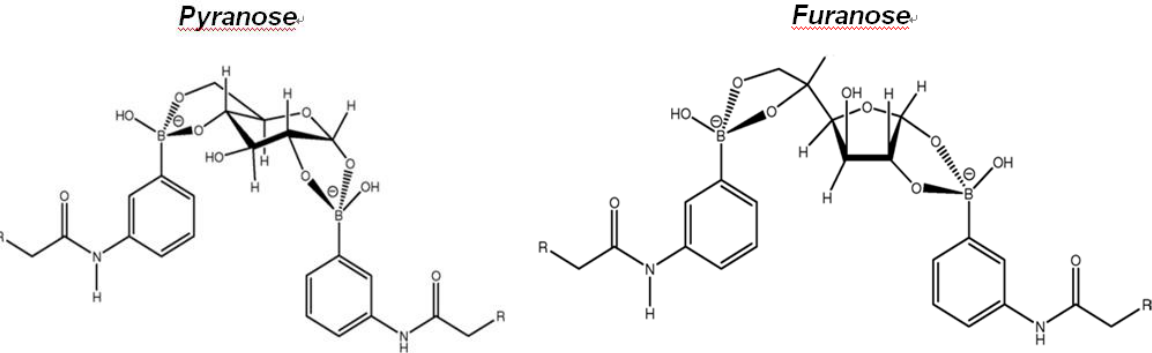
Figure 2. Proposed structures for glucose-PBA bridges between separate chains [8,12,27–29]. Glucose may be in its pyranose ( left ) or furanose ( right ) form. Adapted with permission from